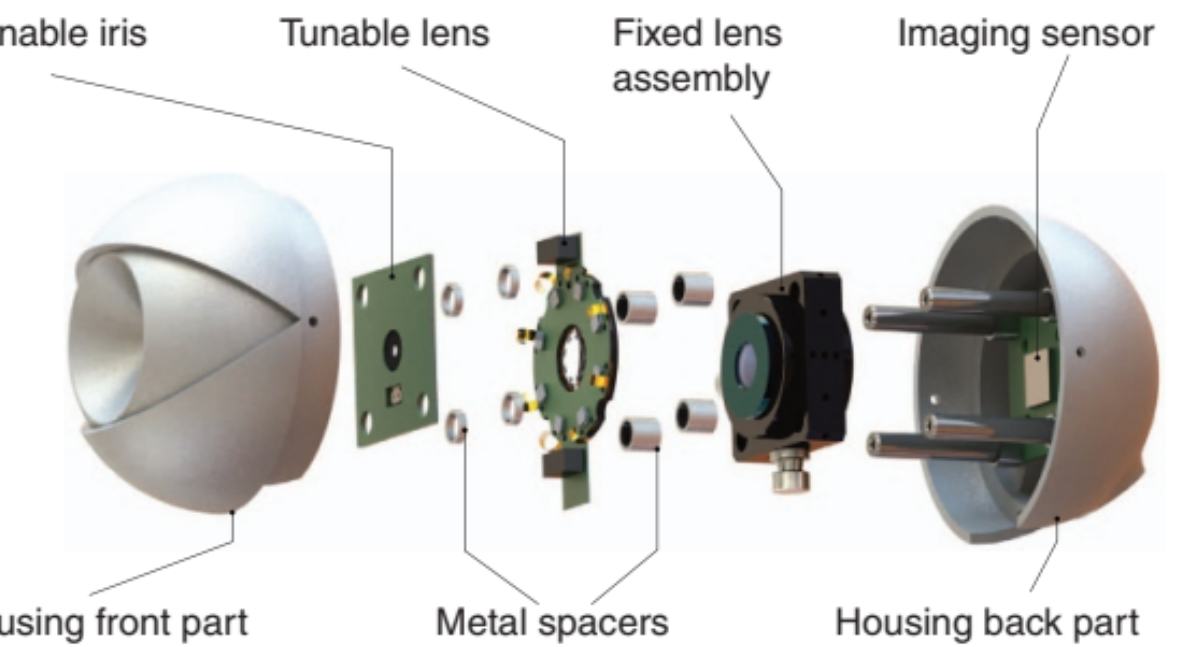
Figure 19. Exploded view of the engineered eyeball assembly constructed by Petsch et al. Light: Science and Applications 2016, 5, e16068 ([62]). Originally published by and re-printed with permission from Springer Nature.